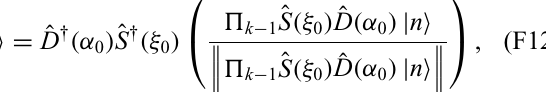
ˆ S (ξ 1 ) ˆ D (α 1 ) | 0 (cid:3) ⊗